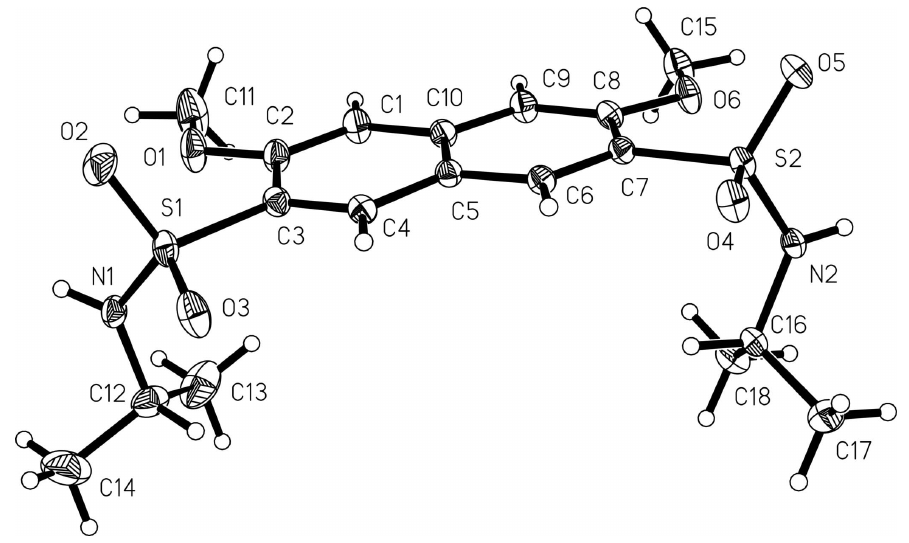
Figure 1 The molecular structure of (I), with atom labels and 40% probability displacement ellipsoids for non-H